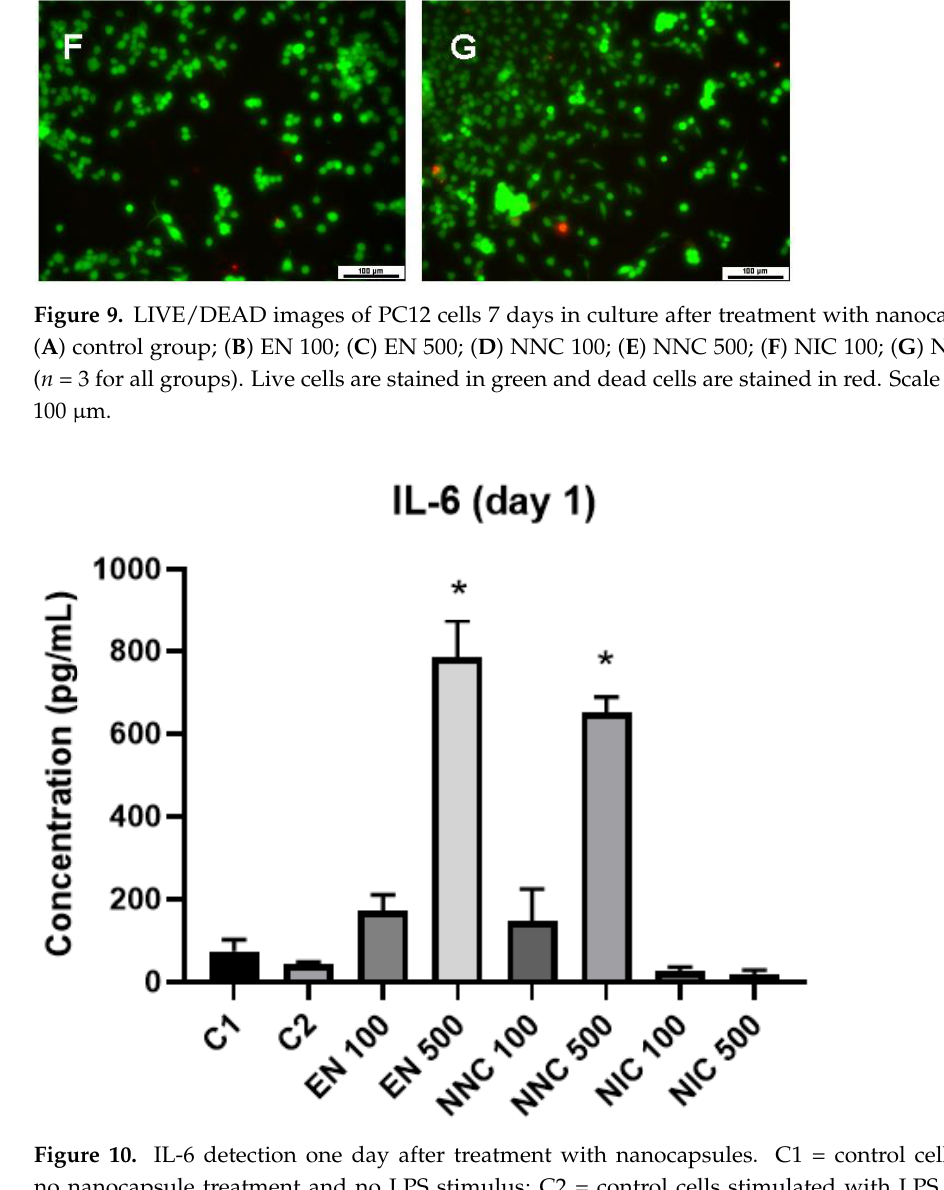
Figure 10. IL-6 detection one day after treatment with nanocapsules. C1 = control cells with no nanocapsule treatment and no LPS stimulus; C2 = control cells stimulated with LPS but no nanocapsule treatment. EN500 and NNC500 presented significantly higher levels of IL-6 compared to C1 (*: p < 0.05 samples vs. control).